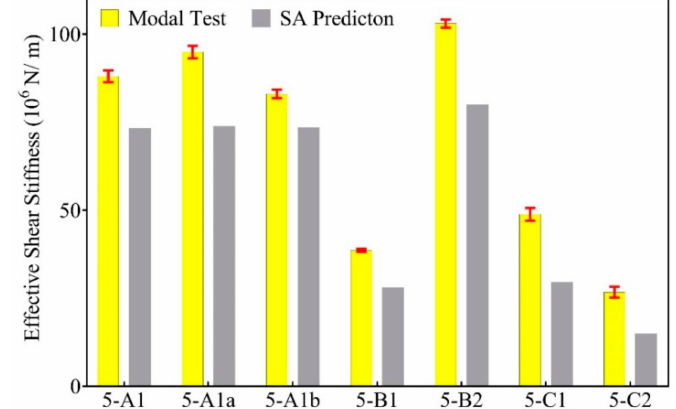
Figure 6. Effective shear stiffness of 5-layer MTPs by modal test and shear analogy method.